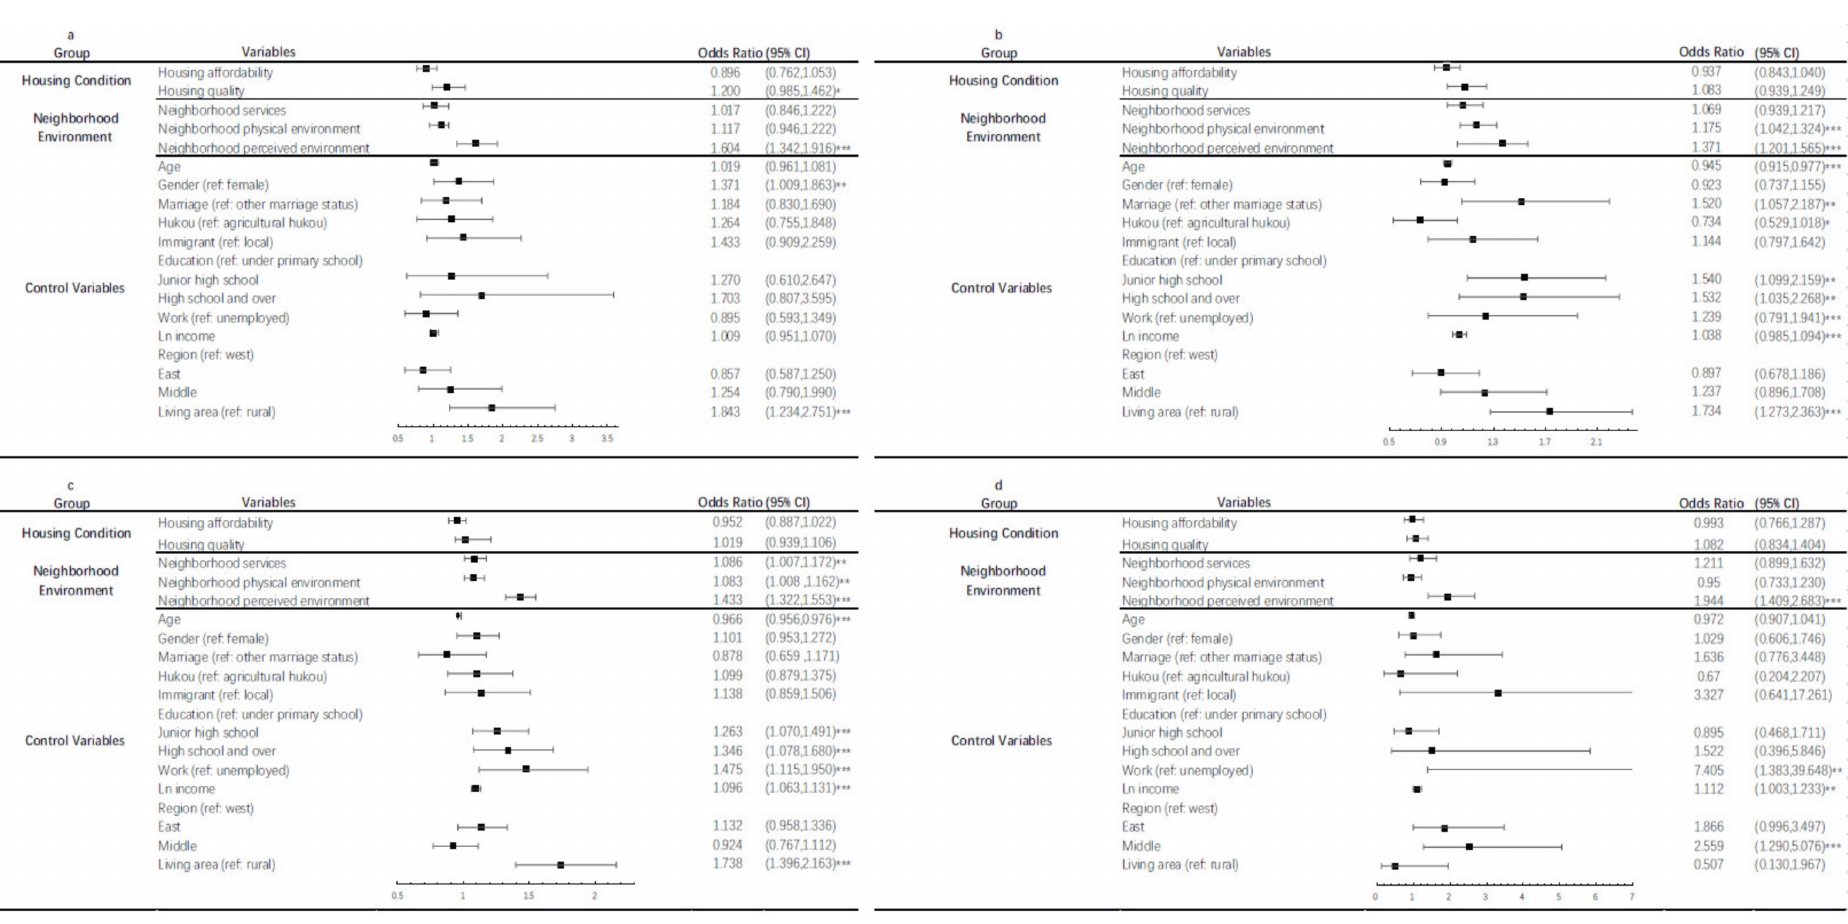
Figure 1. Results of the impact of built environment on physical health among different age groups: ( a ) age under 28, ( b ) age between 29 and 40, ( c ) age between 41 and 65 and ( d ) age over 66. Note: (1) 95% confidence interval in parentheses; (2) * p < 0.1; ** p < 0.05; *** p <